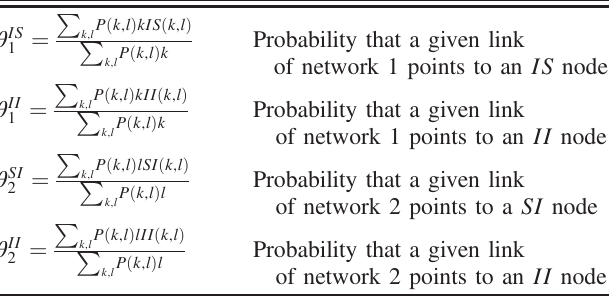
TABLE II. Definition of parameters θ